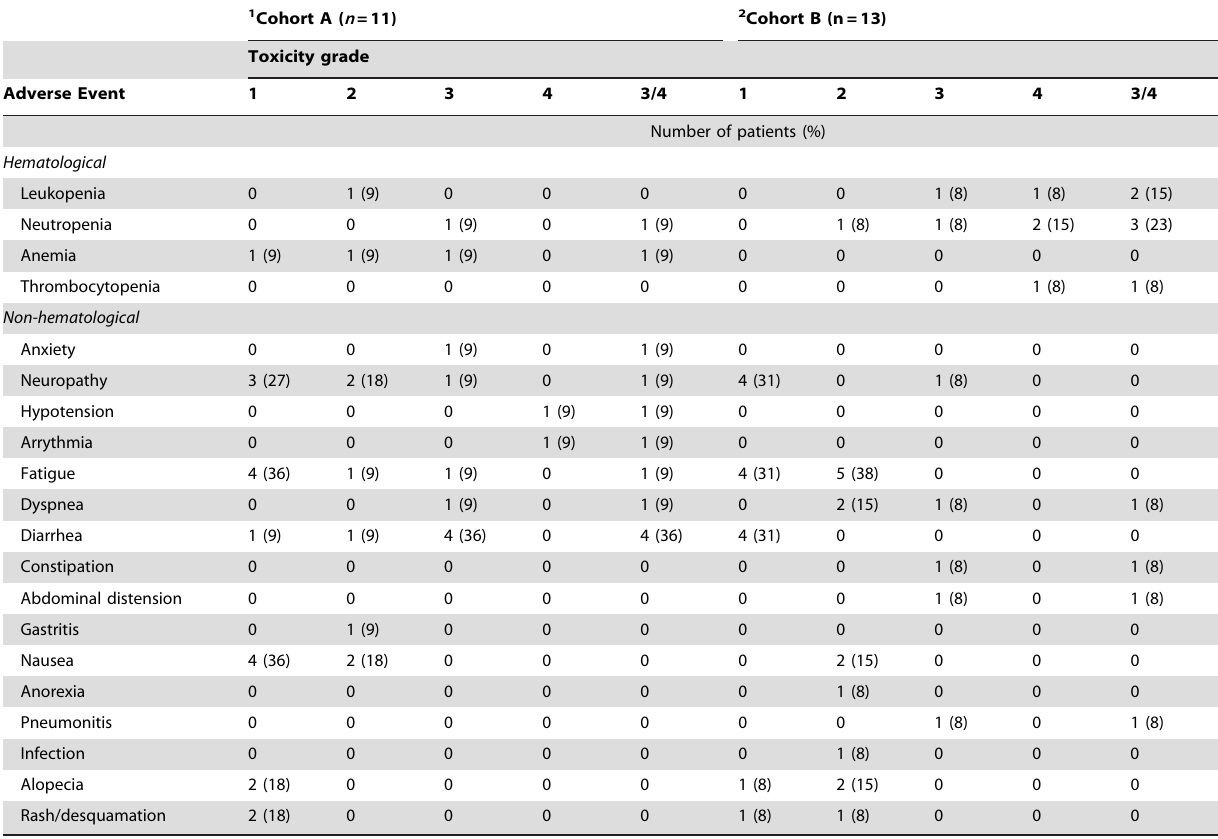
Table 4. Toxicity